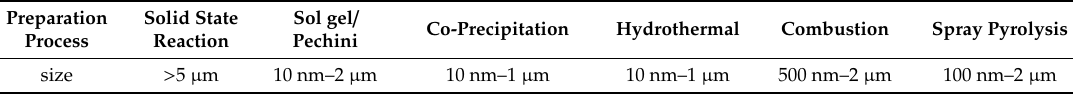
Table 3. Overview of the phosphor particle sizes obtained by different preparation processes [58]. Preparation